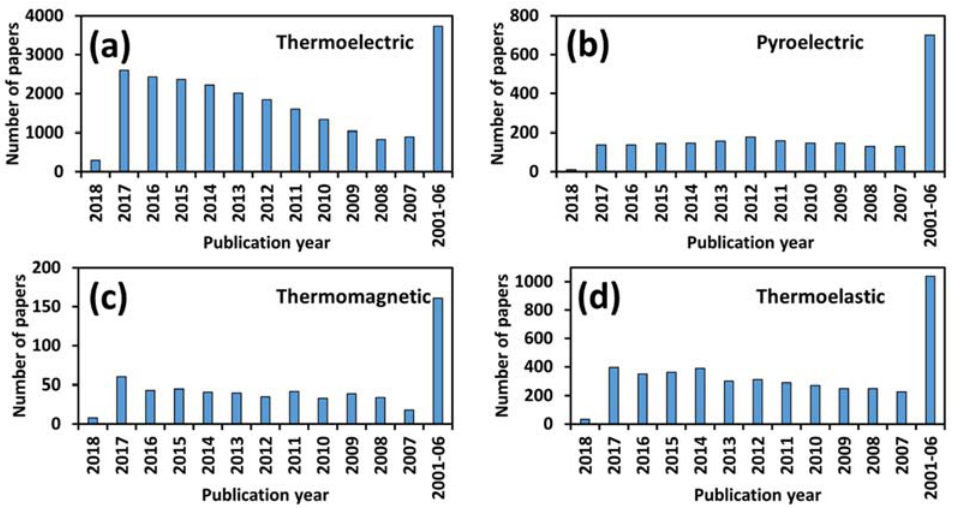
Figure 2. Number of scientific papers published in the field of ( a ) thermoelectric, ( b ) pyroelectric, ( c ) thermomagnetic, and ( d ) thermoelastic effect from the year 2001 to present. These numbers